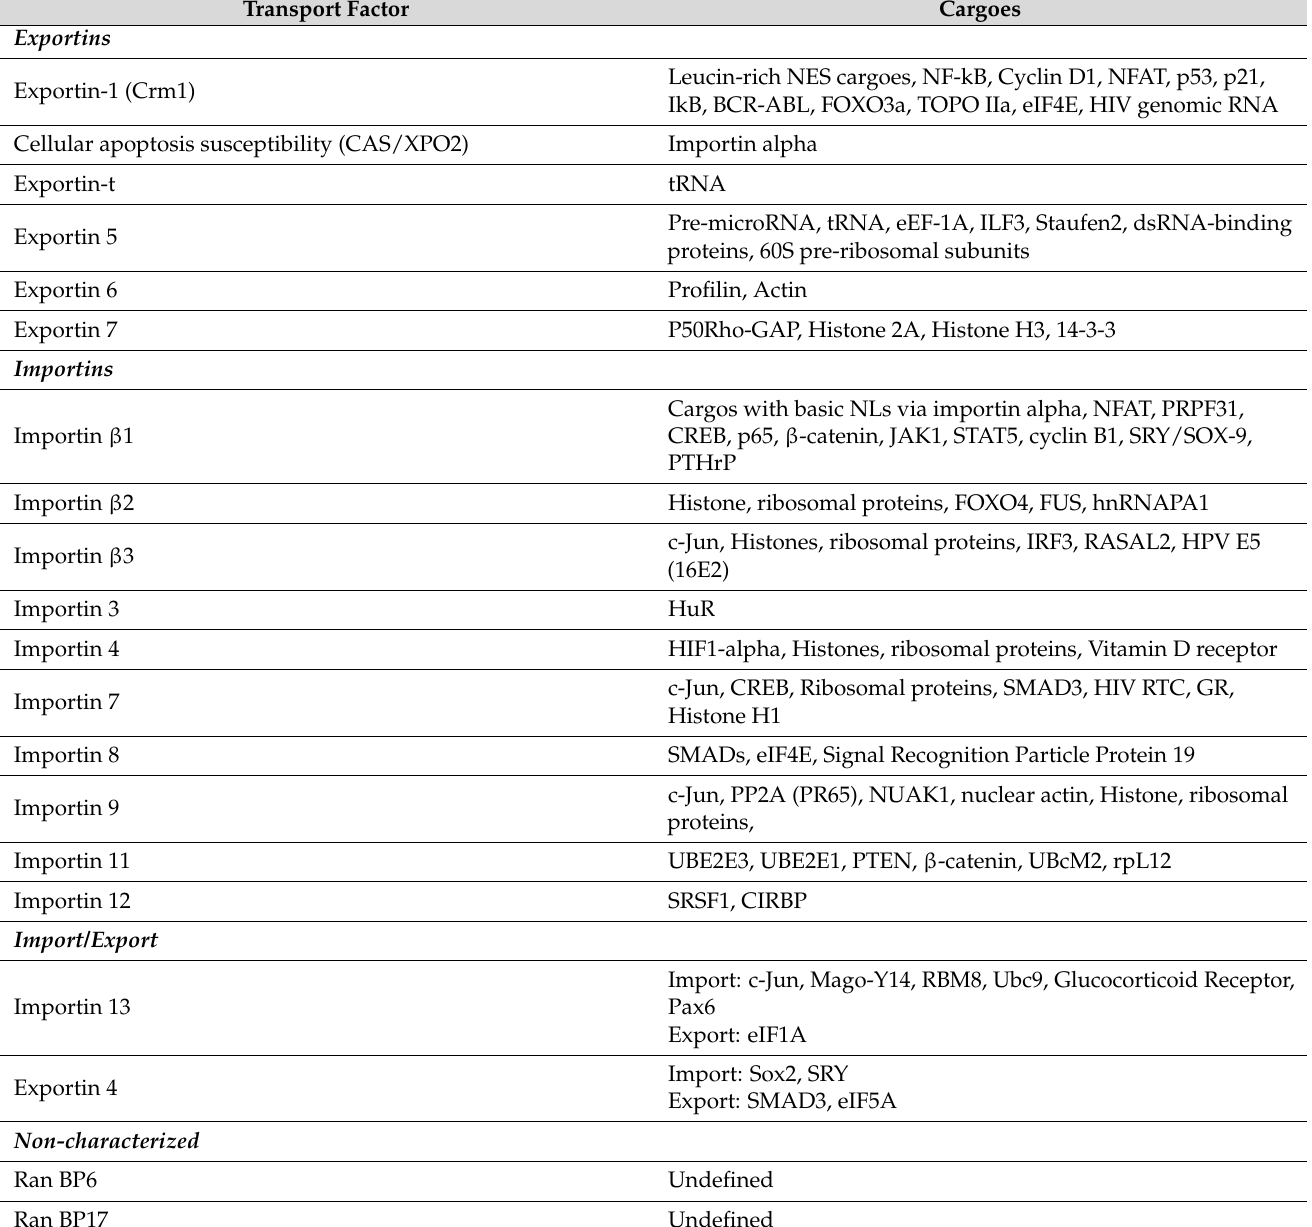
Table 1. Nucleocytoplasmic transport factors with examples of their